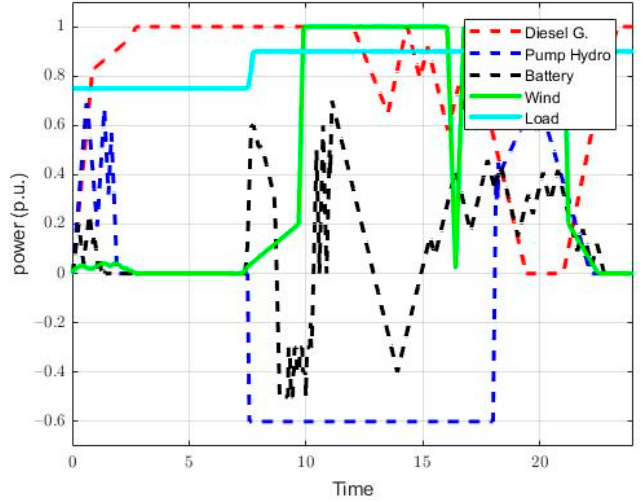
Figure 10. Power response of the microgrid with storage system without full-day solar power.